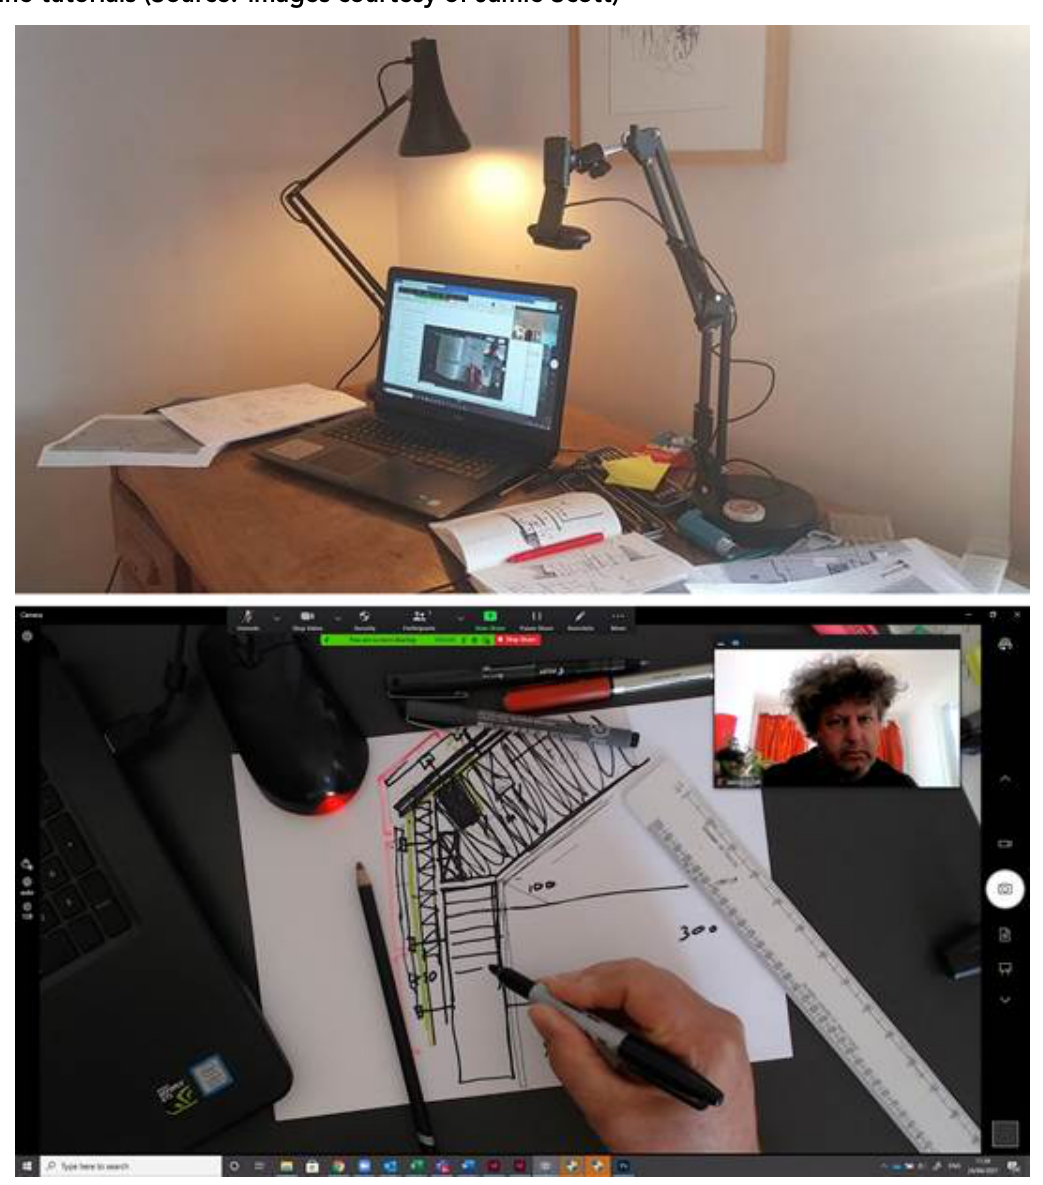
Figure 3. Jamie Scott using two webcams to capture physical sketching and facial contact during online tutorials (Source: images courtesy of Jamie